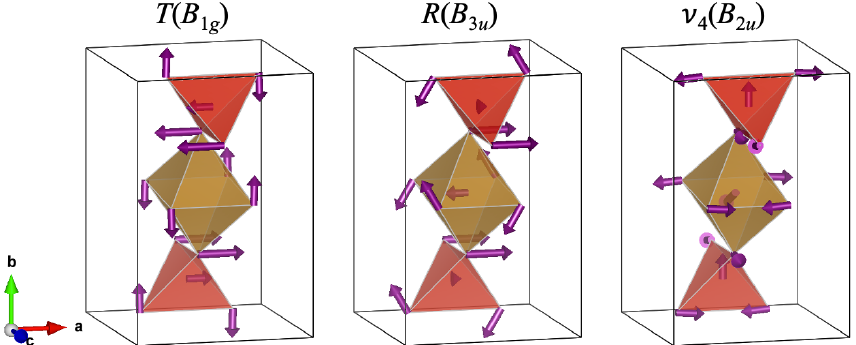
Figure 7. Eigenvectors of the phonon frequencies with negative pressure coefficients of FeVO 4 - II . We used the VESTA software [46] to build the structures.